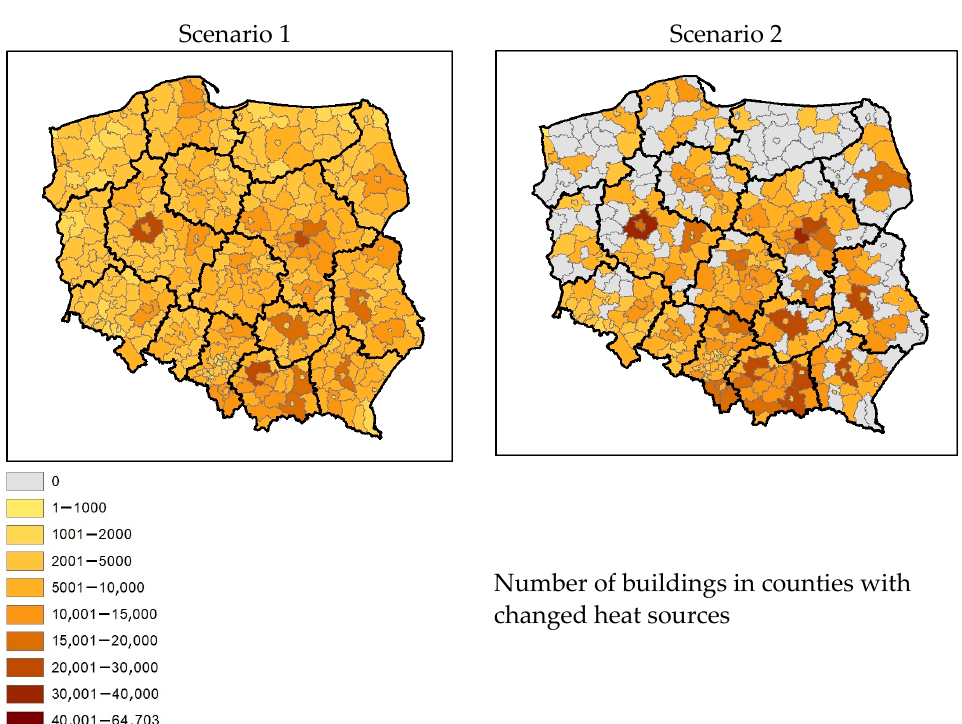
Figure 2. Number of buildings in counties with changed heat sources in scenarios 1 and 2.